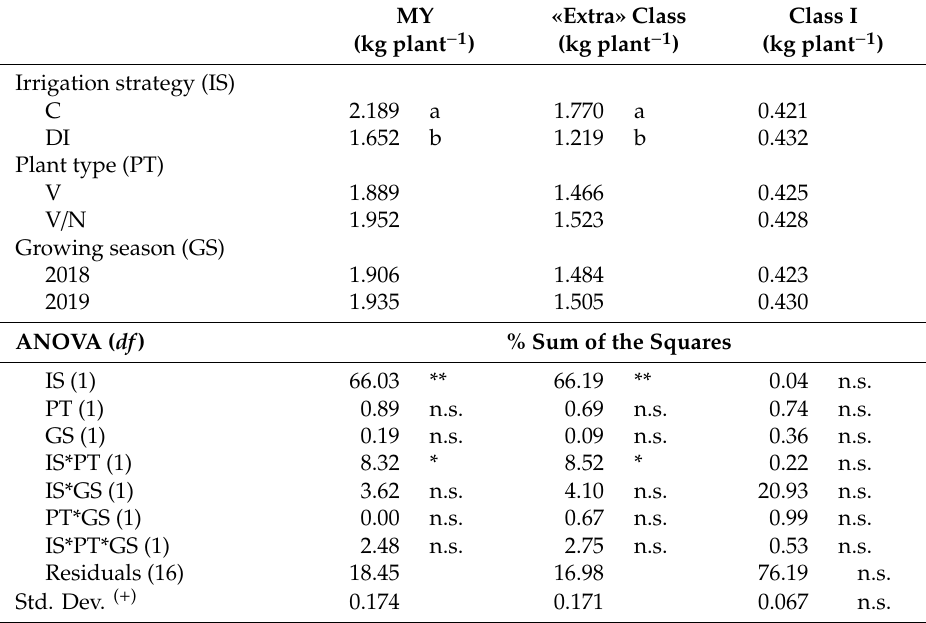
The mean values followed by the di ff erent lowercase letters in each column indicate significant di ff erences at p ≤ 0.05 using the LSD test. ** and * indicate significance at p ≤ 0.01 and p ≤ 0.05, respectively, n.s. no significant di ff erence. ( + ) Standard deviation, calculated as the square root of the residual sum of squares. df degrees of freedom.